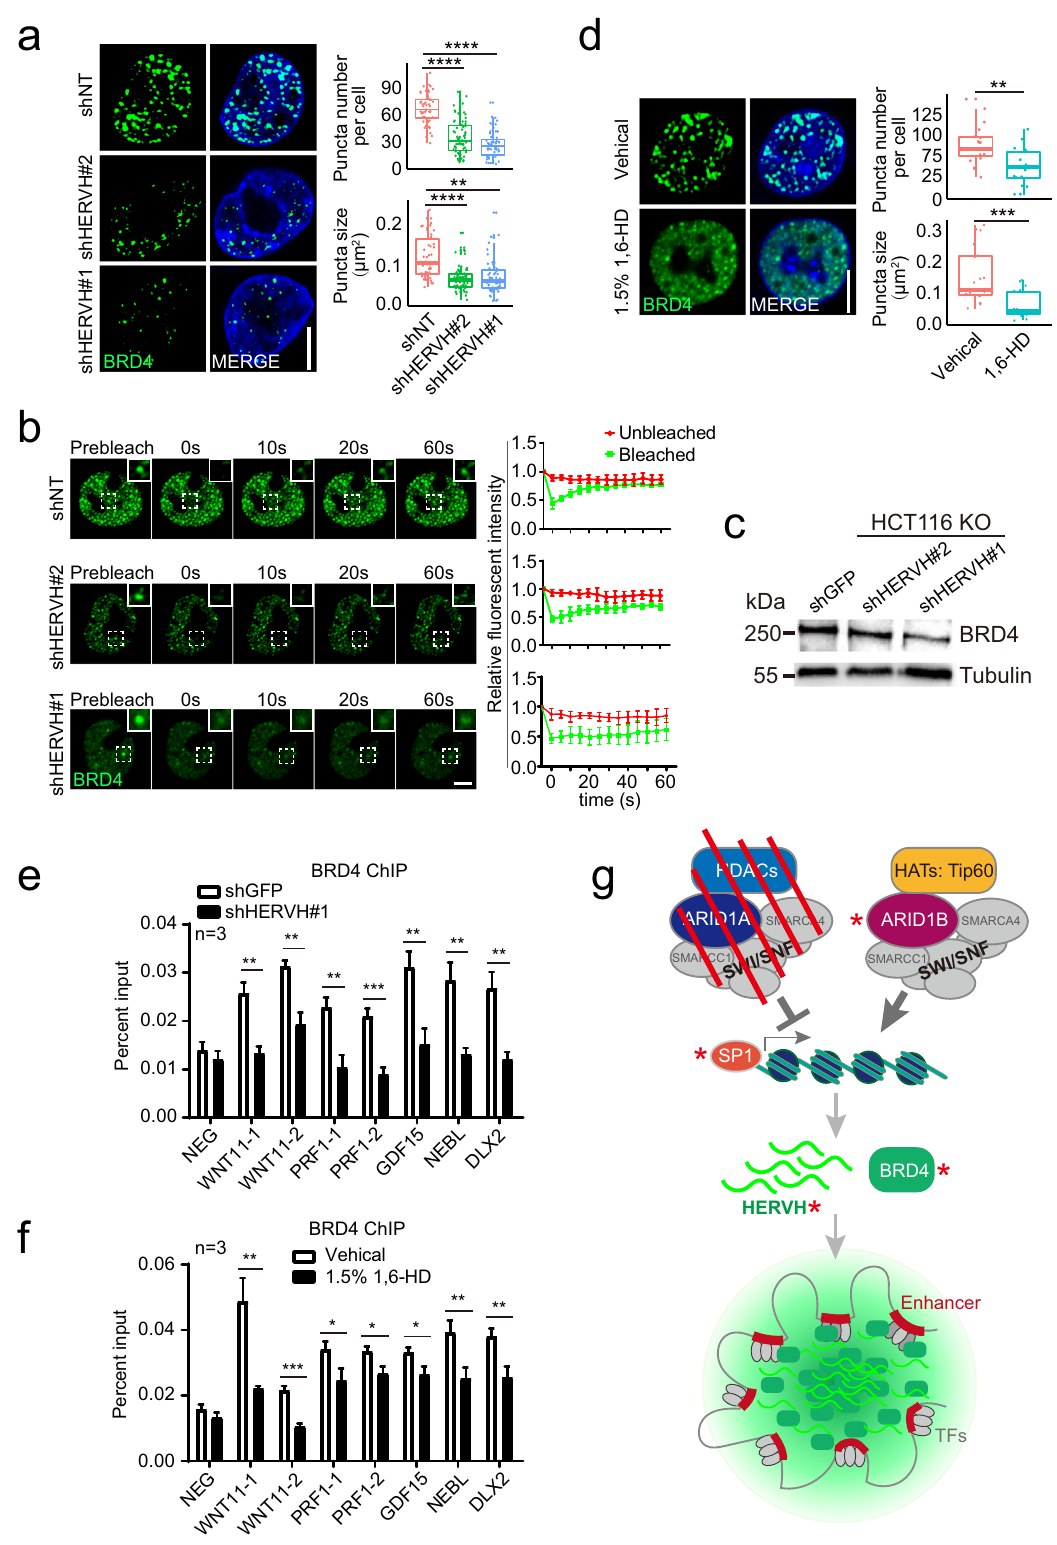
RNA-seq analysis . Raw reads were fi rst cleaned using trim_galore v0.6.0 (http:// www.bioinformatics.babraham.ac.uk/projects/trim_galore/) with default para- meters. The reads from each RNA-seq sample were then mapped to hg38 or mm9 genome assembly downloaded from UCSC, using STAR v2.5.3a 85 . The key alignment parameters were as follows: “ --outFilterMismatchNoverLmax 0.04 --outSAMtype BAM SortedByCoordinate --outFilterMultimapNmax 500 --out- MultimapperOrder Random --outSAMmultNmax 1 ” . Gene expression was NATURE COMMUNICATIONS| (2022) 13:3501